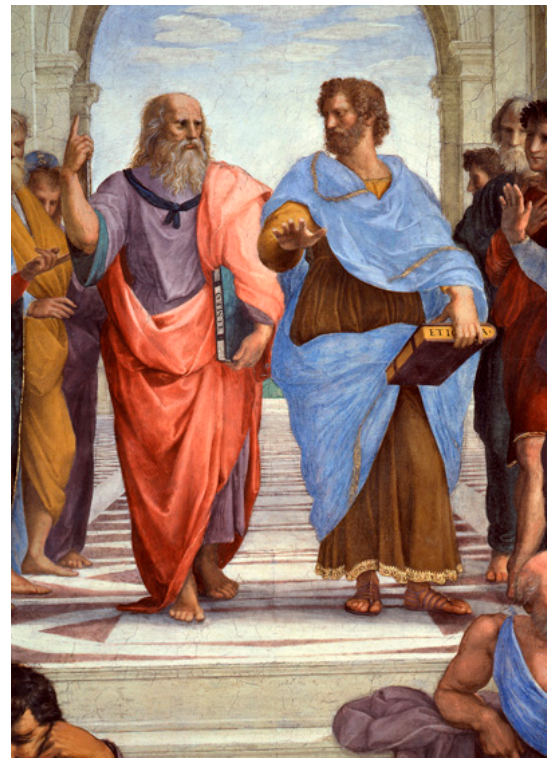
Figure 1. View of the central portion of the Raphael’s School of Athens painted between 1509 and 1511 in the Vatican’s Apostolic Place, depicting a supposed conversation between Plato (left) and Aristotle (right). (Stanza della Segnatura, Palazzi Pontifici, Vatican).